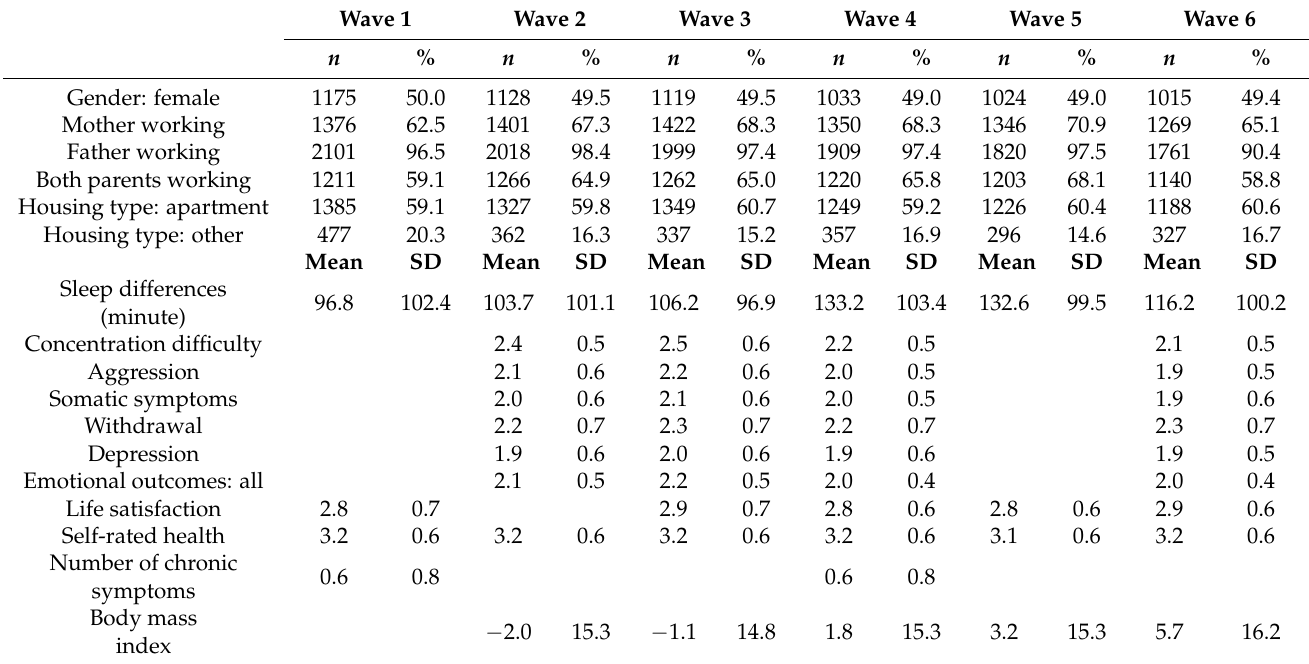
Table 1. Sample characteristics of Korean adolescent